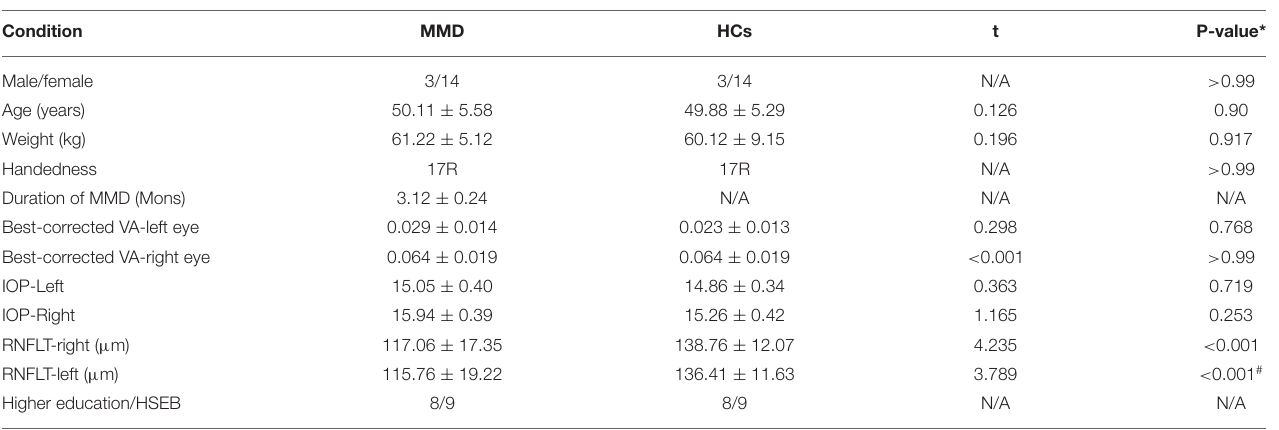
TABLE 1 | Basic information of participants in the